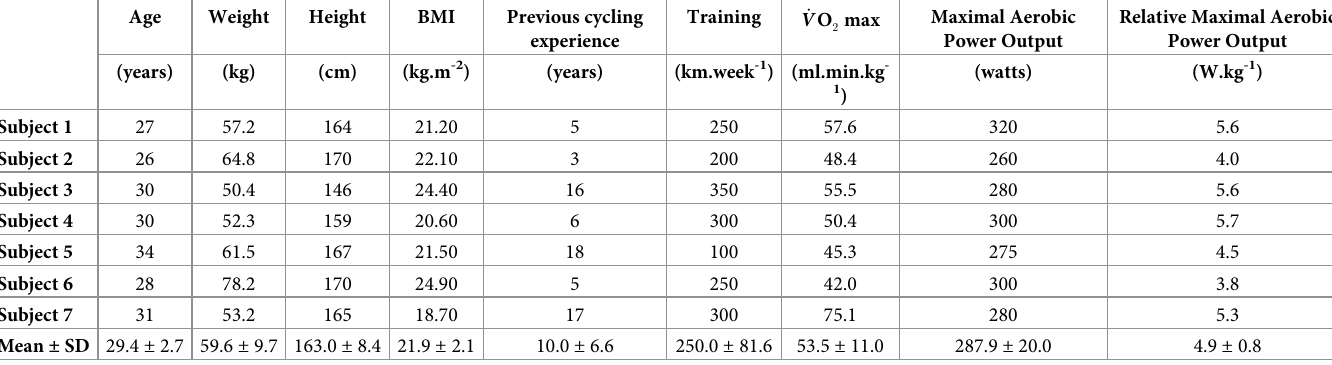
Table 2. Individual characteristics of the subjects participating in the case study.